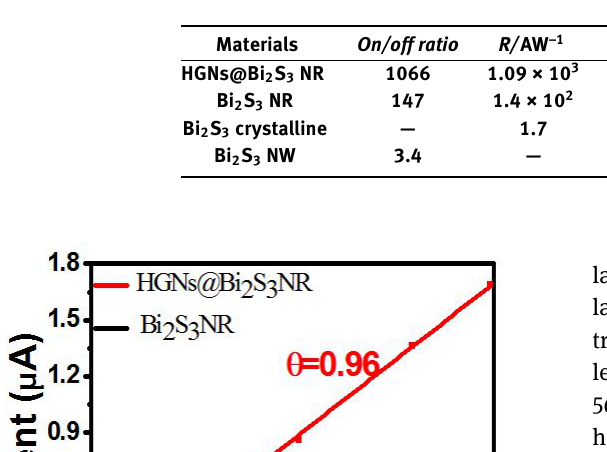
Fig. 5. (a) Schematic illustration of the HGNs@Bi 2 S 3 NR device. (b) I − V curves and responsivity of HGNs@Bi 2 S 3 NR in dark and un- der 560 nm light illumination, the inset is the TEM image of a single NR modified with HGNs. (c) Photoresponsive characteristics of the HGNs@Bi 2 S 3 NR device. (d) Summary of both dark current and photocurrent of 5 representative individual HGNs@Bi 2 S 3 NR based device. Table 1. Comparison of the device performance of the present and other Bi 2 S 3 nanostructures based photodetectors.